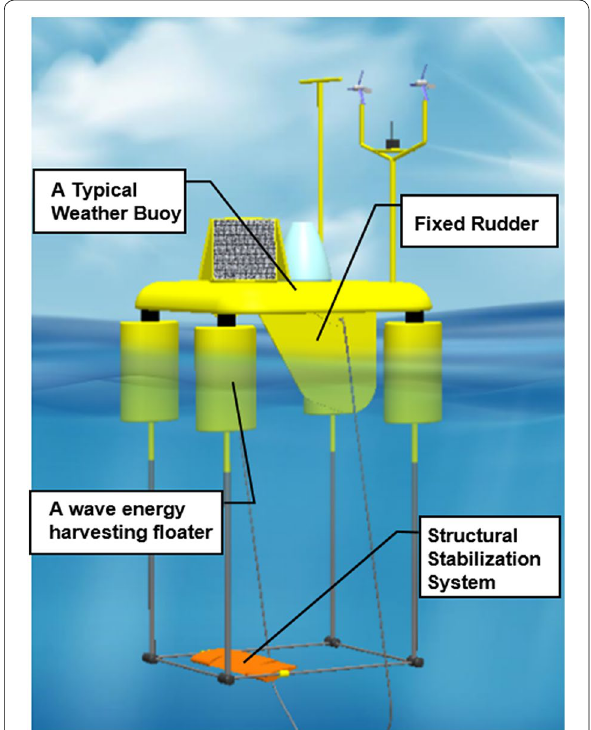
Fig. 1 Concept of final stabilized buoy. Three main parts of proposed stabilized buoy structure, a typical weather buoy with a fixed rudder, four wave energy harvesting floaters at each corner of the buoy, and the structural stabilization system are shown in the figure